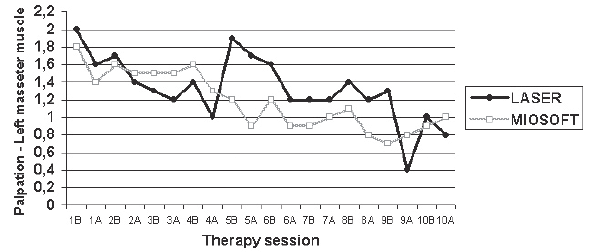
FIGURE 6- Mean of palpation figures of the left masseter muscle, before and after each therapy